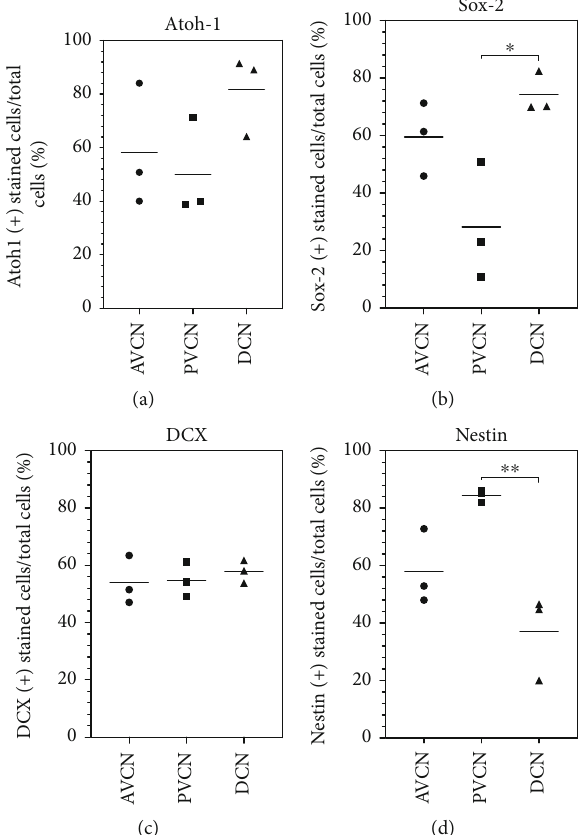
Figure 9: Propagated single cells of all CN subnuclei express neural stem cell markers. Analysis of the distribution of neural stem cell markers of single-cell cultures of CN subnuclei — obtained from neurosphere cultures over 4 weeks. The graphs show the proportions of cells positively marked after 24h. The β -tubulin-positive cells were evaluated as absolute cell numbers. (a) Atoh-1 was stained positively on average in 50 – 82% of the grown single cells of AVCN, PVCN, and DCN ( n = 3 ; mean). There were no signi fi cant di ff erences between the subnuclei. (b) On average, 6% of the single cells of the AVCN, 28% of the PVCN, and 74% of the DCN were labeled Sox-2-positive ( n = 3 ). The expression of this transcription factor was shown most frequently in dissociated cells of the DCN cultures. (c) The progenitor cell marker doublecortin (DCX) was expressed on average from 54 – 58% of the plated single cells — without signi fi cant di ff erences among the subnuclei ( n = 3 ). (d) The neural stem cell marker nestin was expressed on average by 58% of the plated single cells of the AVCN, by 84% of the PVCN, and by 37% of the DCN. The PVCN signi fi cantly showed the highest proportion of positively labeled single cells ( n = 3 ). Box plots show the median with the upper and lower quartiles, and whiskers mark the upper and lower maximum values; asterisks indicate the signi fi cance level: ∗ p < 0 : 05 , ∗∗ p < 0 : 005 , ∗∗∗ p < 0 : 001 , and ∗∗∗∗ p < 0 : 0001